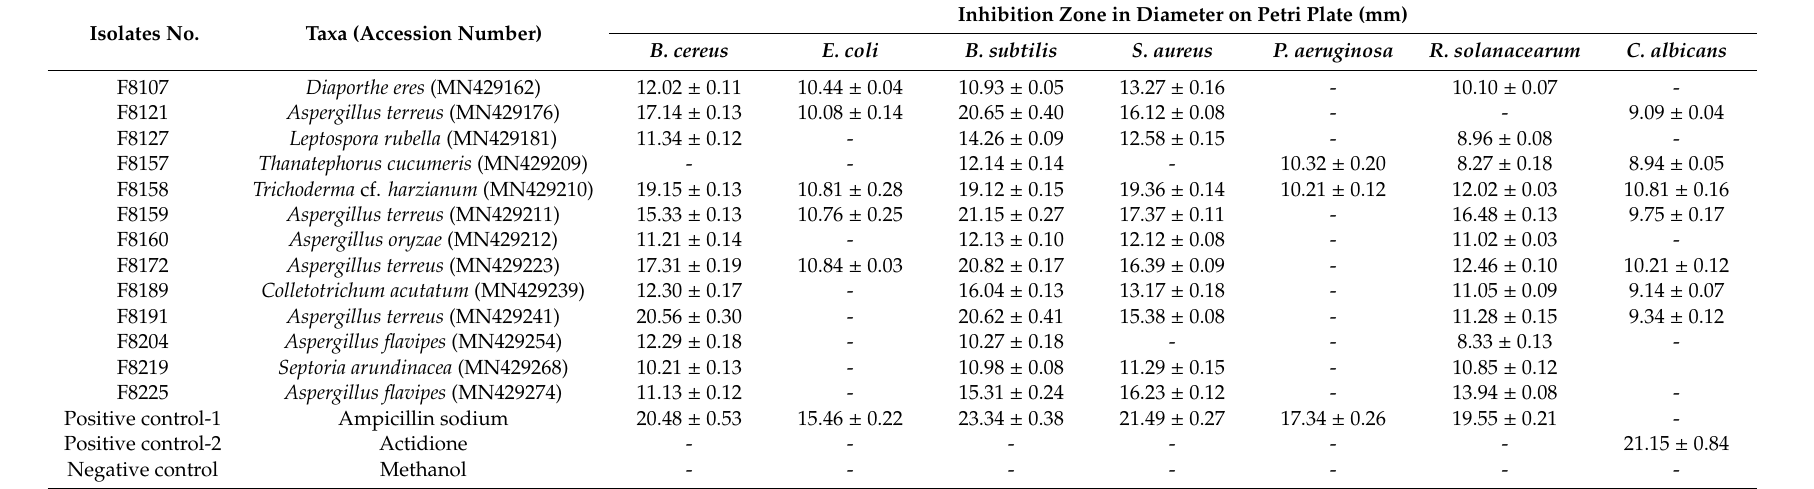
Table 3. Antimicrobial activities of culturable endophytic fungi from C. japonicus